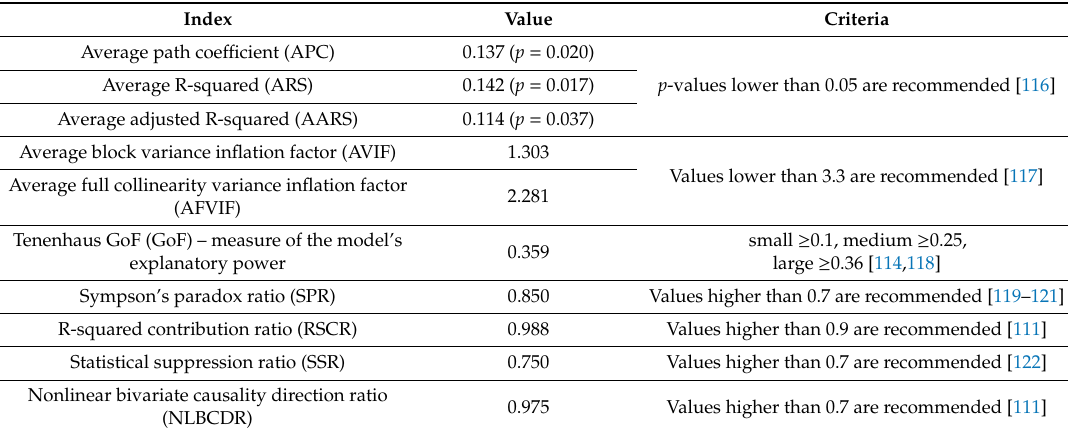
Table 4. Model fit and quality